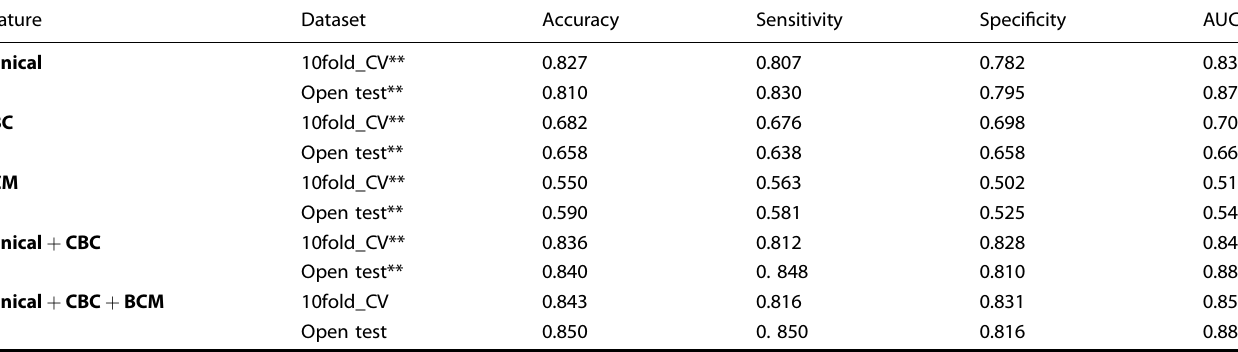
Table 3. Classi fi cation performance of XGBoost using clinical features, hematologic biomarkers and their combination, based on the entire cohort.